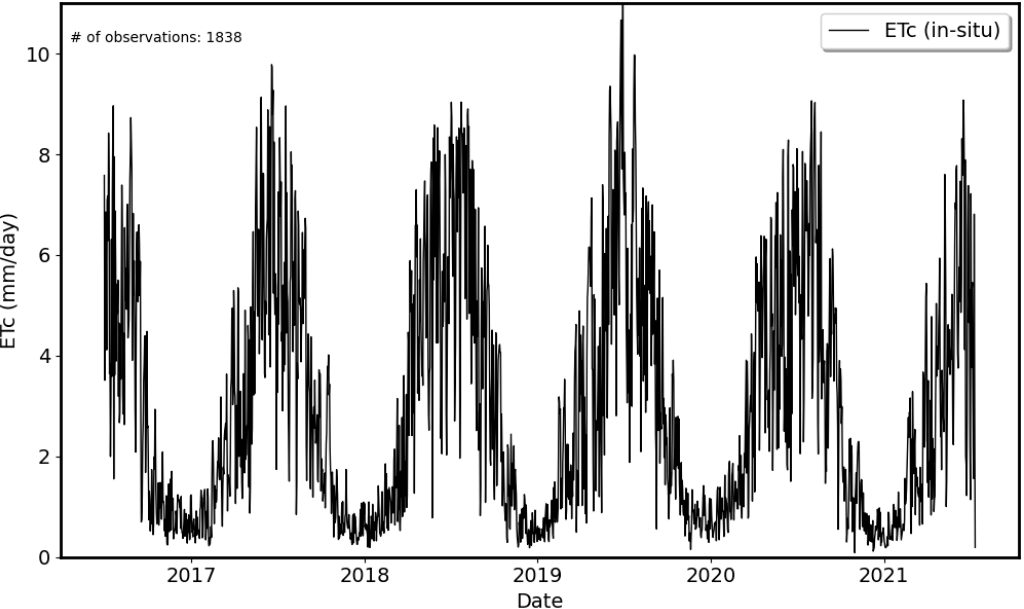
Figure 4. Daily Evapotranspiration time series calculated from the meteorological data of one weather station (Burkersdorf) using the FAO Penman–Monteith approach.